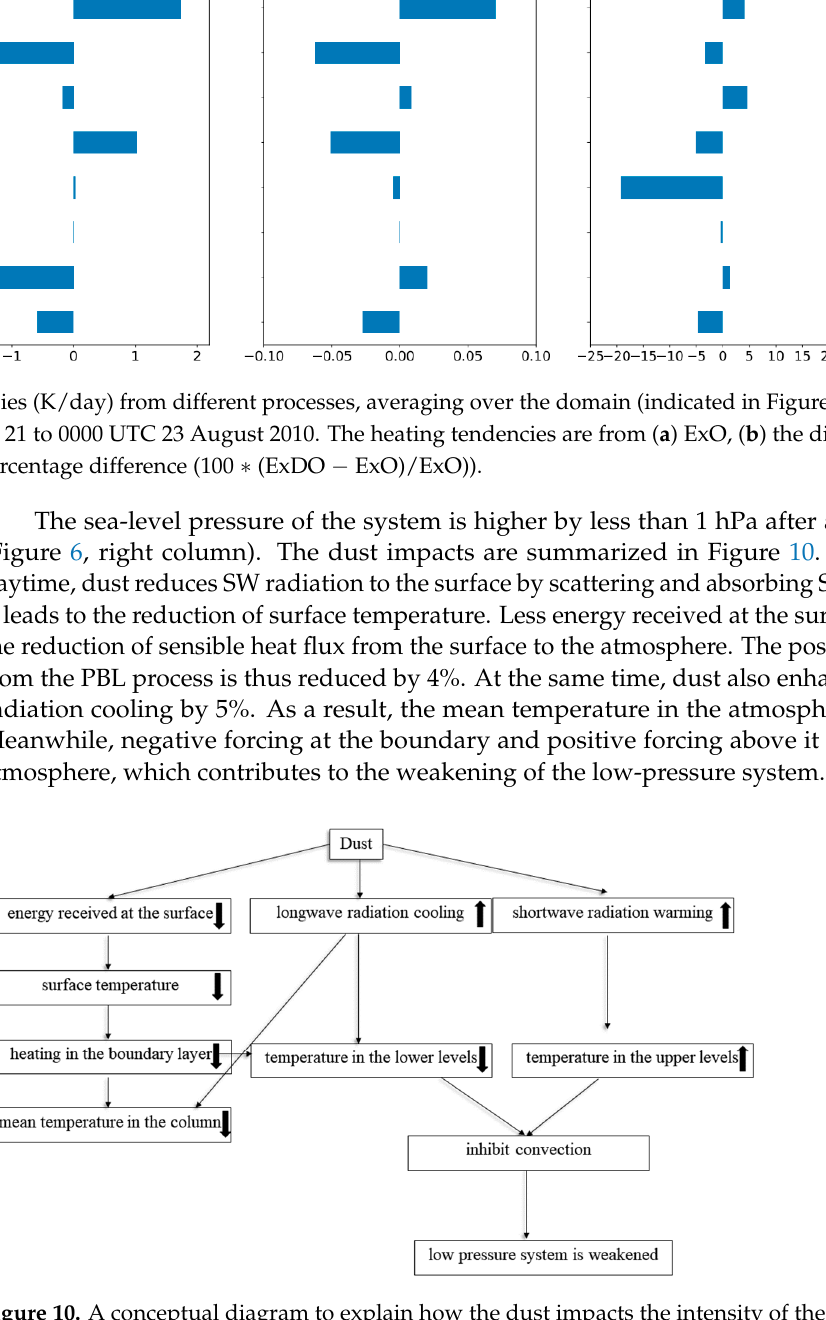
Figure 10. A conceptual diagram to explain how the dust impacts the intensity of the low-pressure system over North Africa.